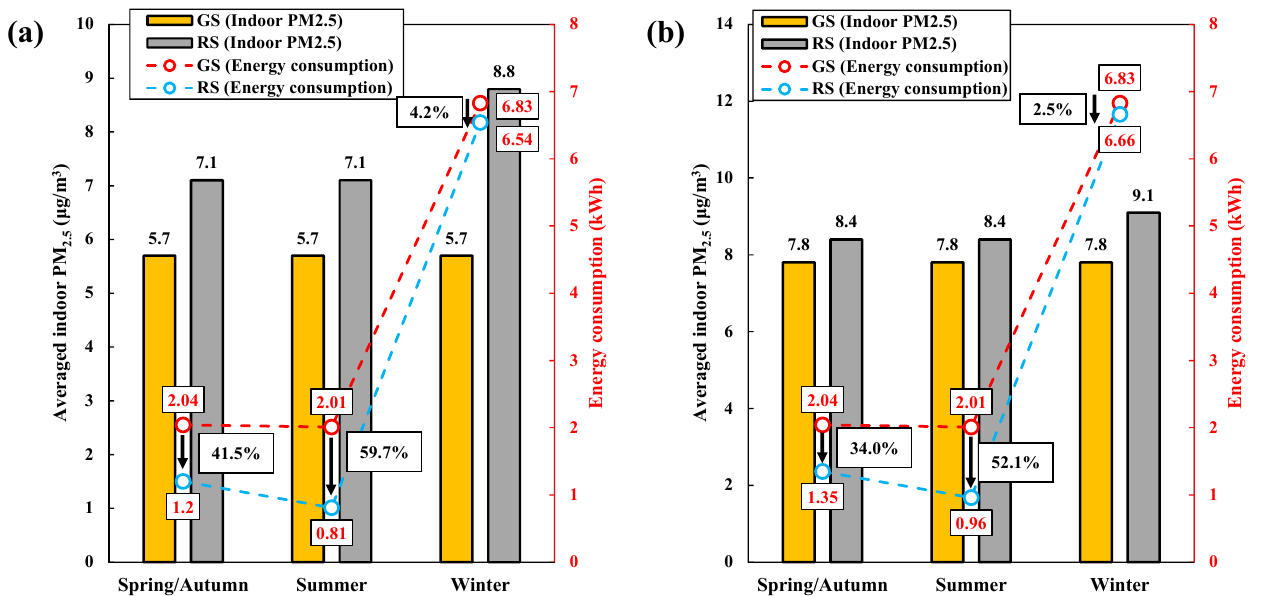
Figure 8. Averaged indoor PM 2.5 and energy consumption in general energy consumption and energy consumption reduction scenarios (GS: general scenario, RS: reduction scenario). ( a ) Outdoor PM 2.5 : 15 µ g/m 3 . ( b ) Outdoor PM 2.5 : 50 µ g/m 3 .